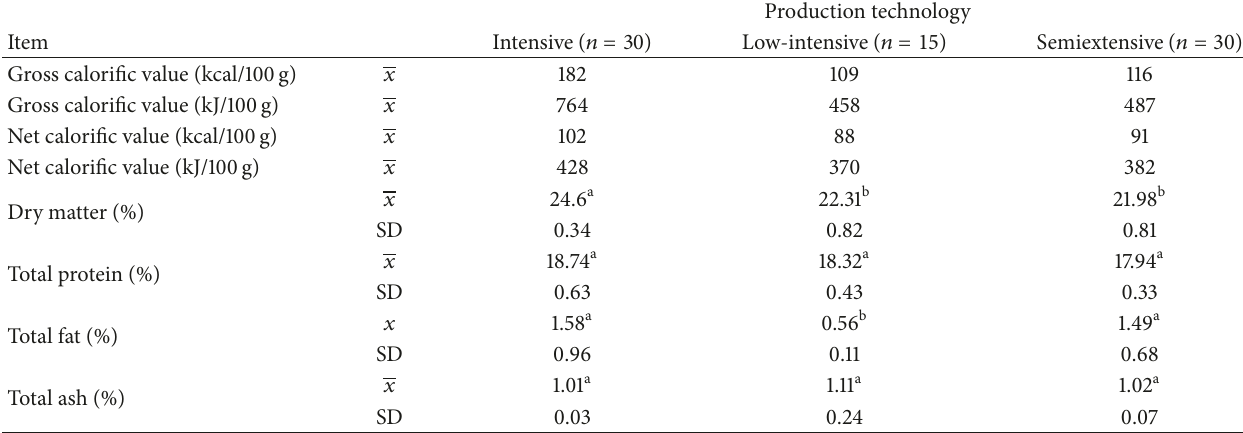
Table 1: Calorific value and basic chemical composition in muscle tissue of common carp samples under study.